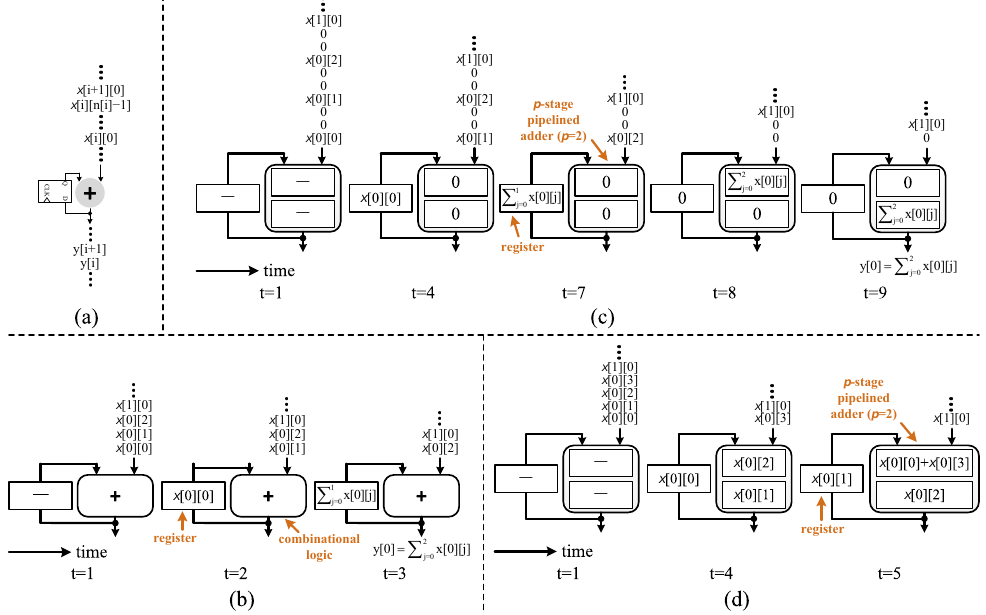
Figure 2. ( a ) A simple reduction circuit example; ( b ) use a combinational logic reduction operator x [ 0 ][ j ] ; ( c ) use a p -stage pipeline reduction operator to calculate y [ 0 ] = to calculate y [ 0 ] = ∑ 2 j = 0 ∑ 2 x [ 0 ][ j ] , where p = 2; ( d ) if an operation is required to be performed once in a clock cycle, the j = 0 solution ( c ) can only reduce the input data to p + 1 partial results, where p =